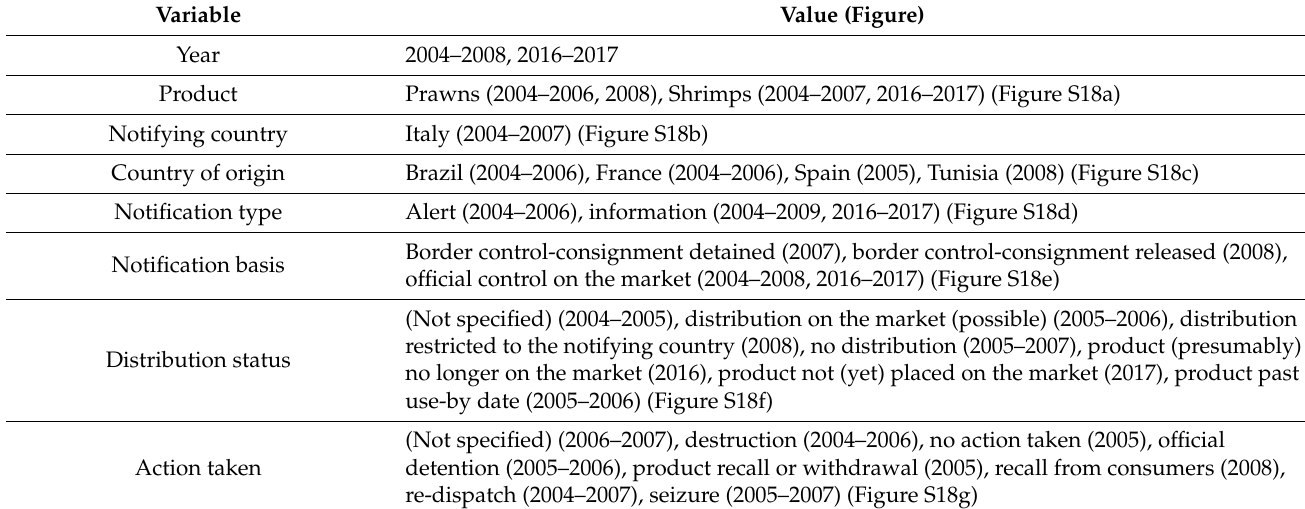
Table 10. Results of two-way joining cluster analysis related to notifications on additives/allergens (sulphite) in seafood in the RASFF in